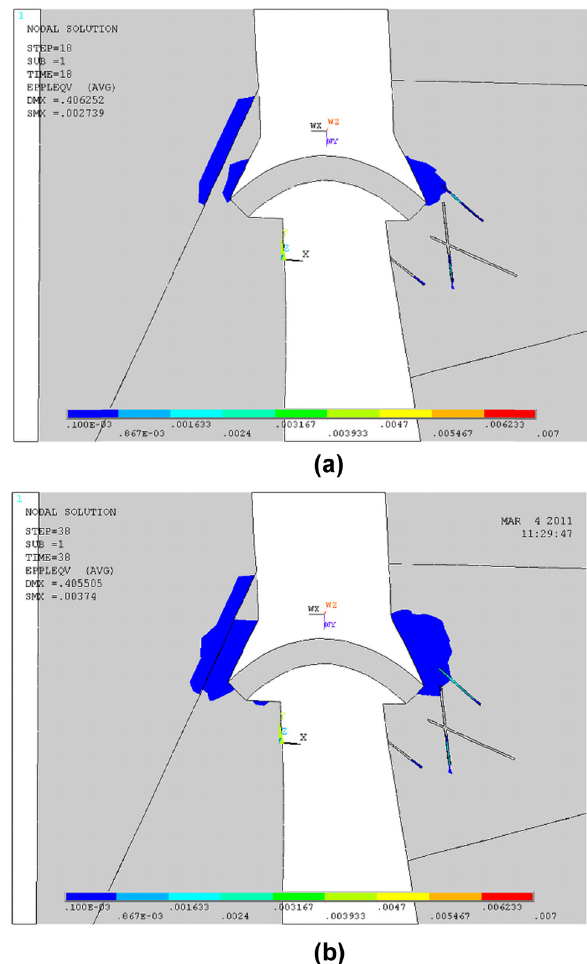
Figure 19: ( a ) Plane section diagram of plastic zone ( K = 4.0 ▽ 2,030 m ) . ( b ) Plane section diagram of plastic zone p ( K = 8.0 ▽ 2,030 m ) p